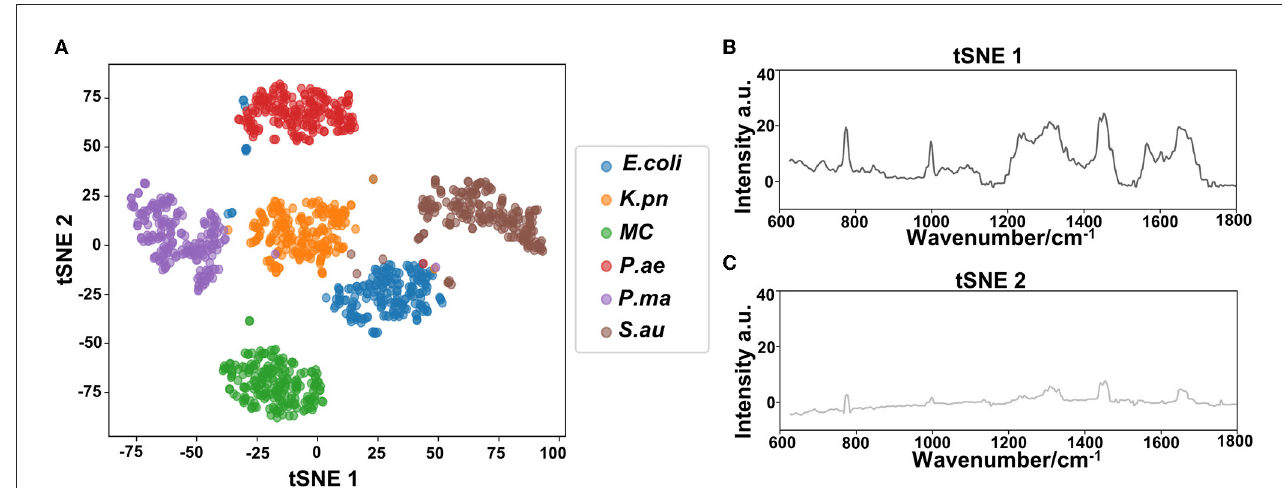
FIGURE3 Classification analysis of six respiratory pathogens. (A) t-SNE visualization analysis and (B, C) Raman wavenumber loading plots against the contributions of relevant Raman bands to t-SNE1 and t-SNE2 of the